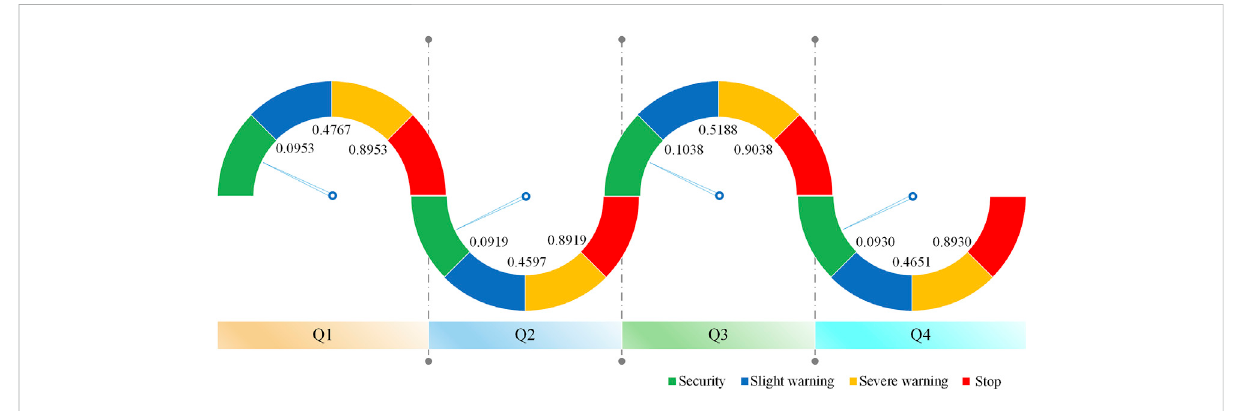
FIGURE 11 The warning signals for Changning play.